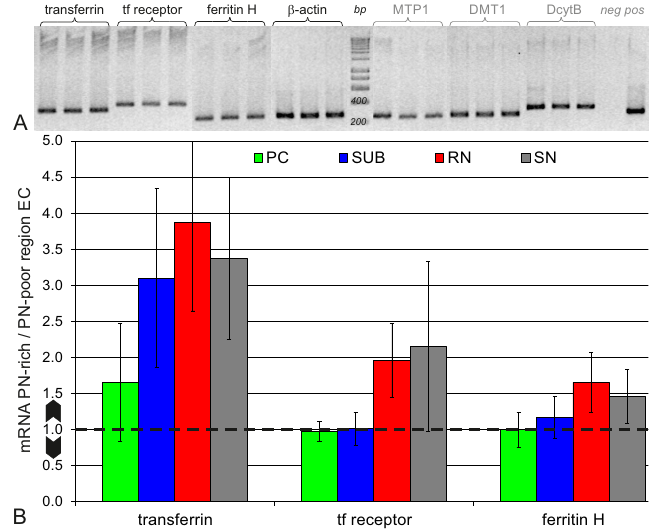
Figure 7. qRT-PCR. ( A ) All cDNA amplification products were verified according to their sequence lengths (data shown for SN). ( B ) Relative quantities of mRNA from PN-rich brain regions with respect to mRNA content in EC (PN-poor region). The dotted line marks the base level ratio of one, i.e., no difference in mRNA expression. Data given as mean ± 95% confidence interval.